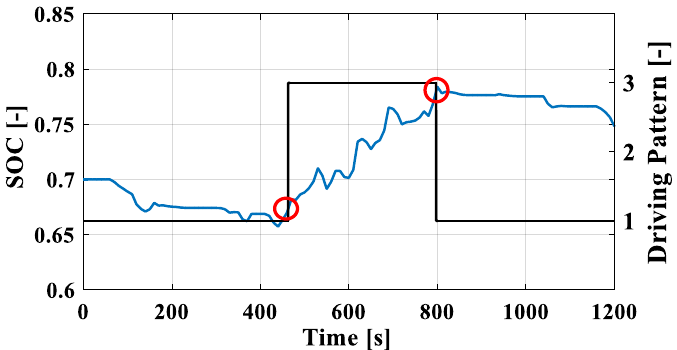
Figure 6. SOC state during driving pattern transition.